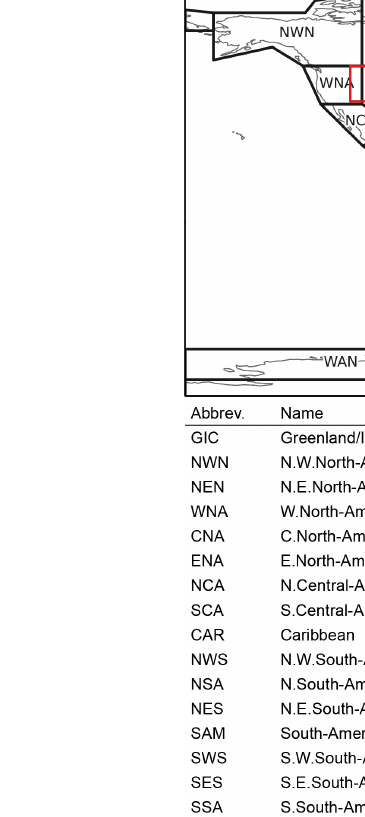
Figure A3. Reference regions of the IPCC AR6 as defined in Iturbide et al. (2020). The event regions used in Sect. 5.1 are indicated in red.